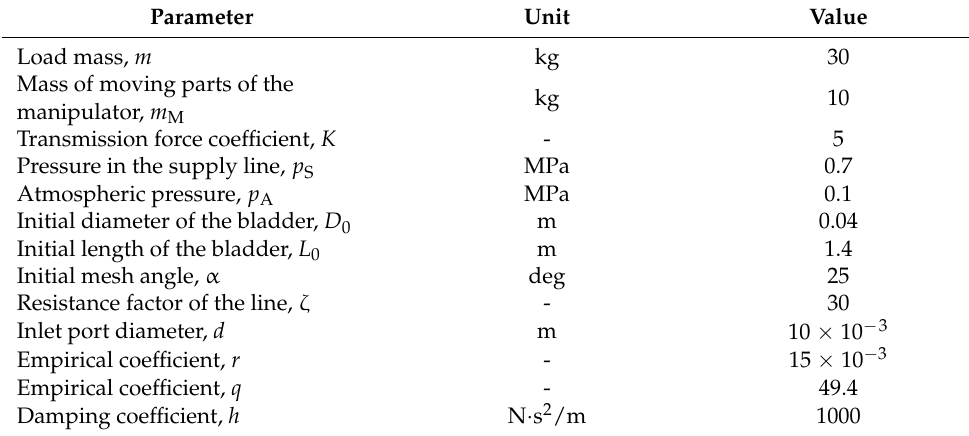
Table 5. Initial parameters for numerical modeling of dynamic characteristics of the manipulator.